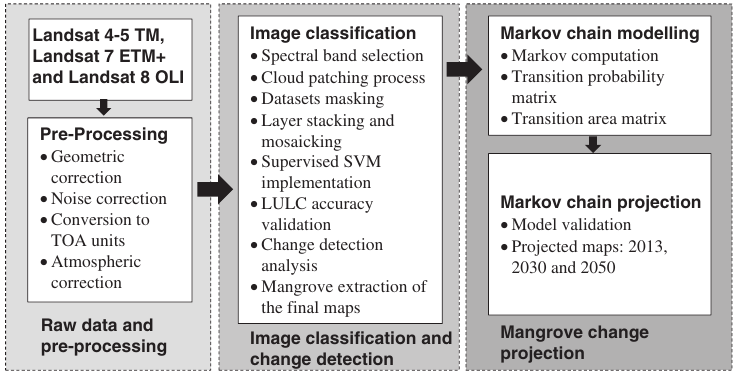
Diagram of multi-temporal mangrove change detection in Palawan using the Landsat imageries, supervised support vector machine classification and the Markov chain